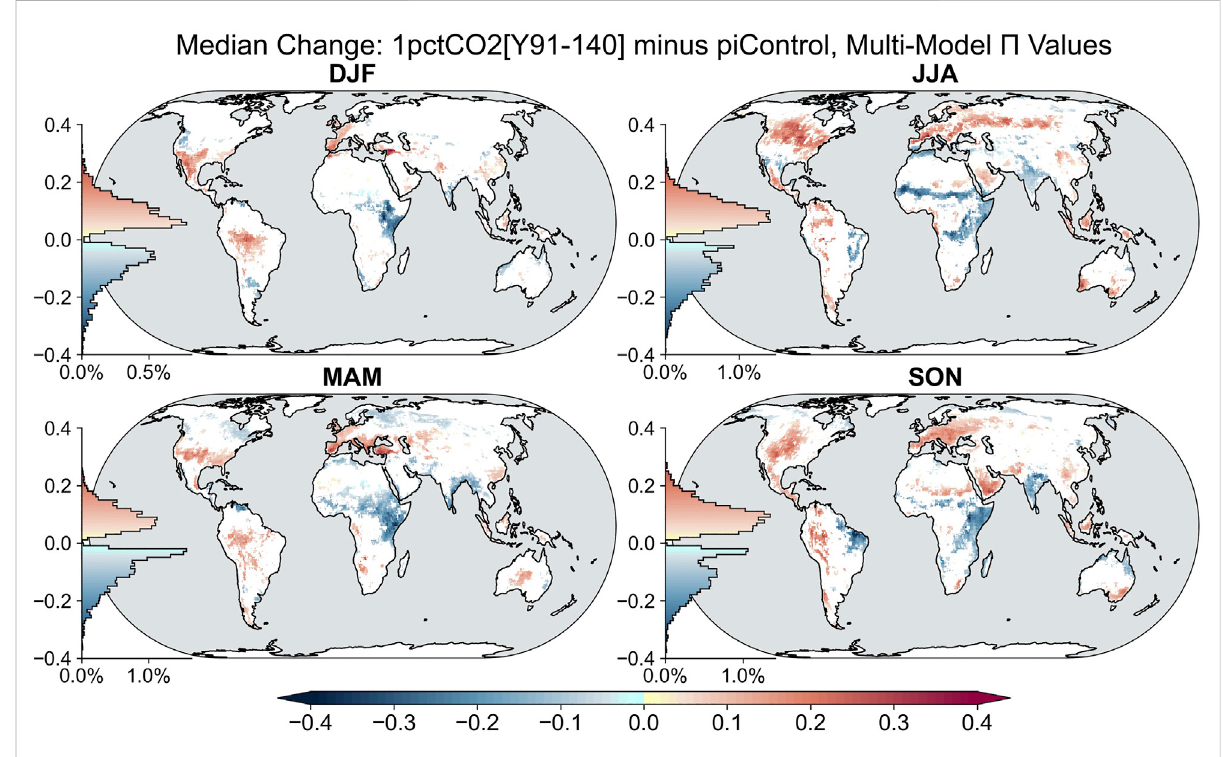
FIGURE 4 As in Figure 2 for the median change in Π (dimensionless) from piControl to years 91 – 140 of the 1pctCO2 simulations (leading up to a quadrupling of CO 2